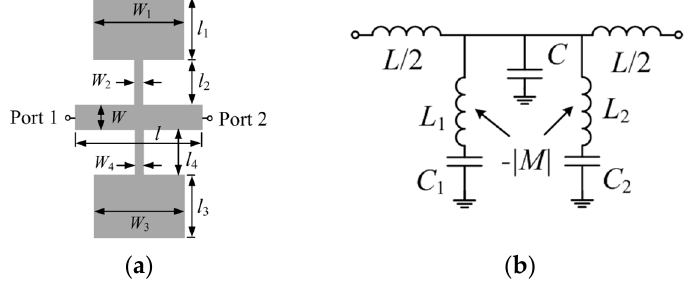
Figure 2. ( a ) Microstrip line section loaded with a pair of SISS; ( b ) lumped element equivalent circuit model.